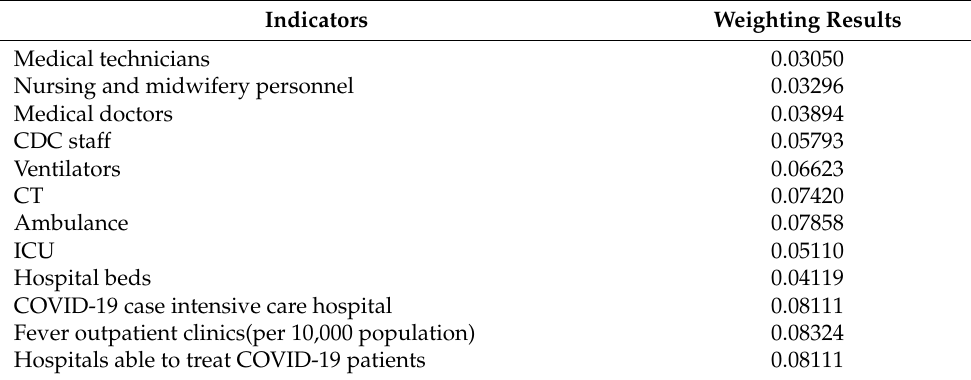
Table 2. Weight distribution of HRCC indicators in 31 provinces in mainland